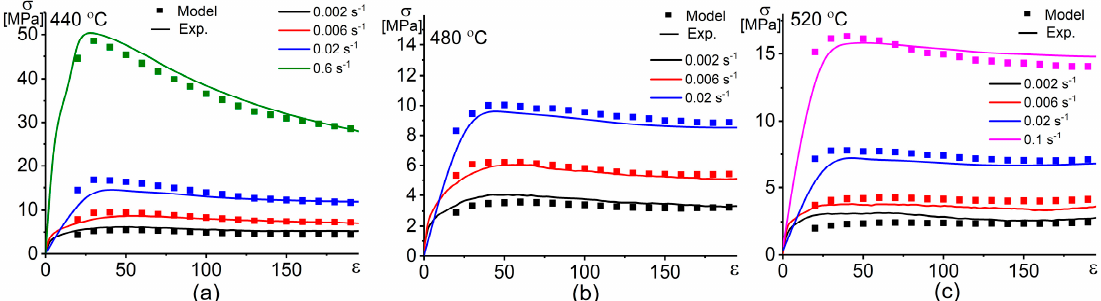
Figure 7. Dependences of the experimental and the predicted by the Arrhenius-type constitutive hyperbolic equation (ACE) model stresses vs. strain at different strain rates and temperatures of ( a ) 440 °C, ( b ) 480 °C, and ( c ) 520 °C. Table 2. Settings of the training parameters for the used neural network.